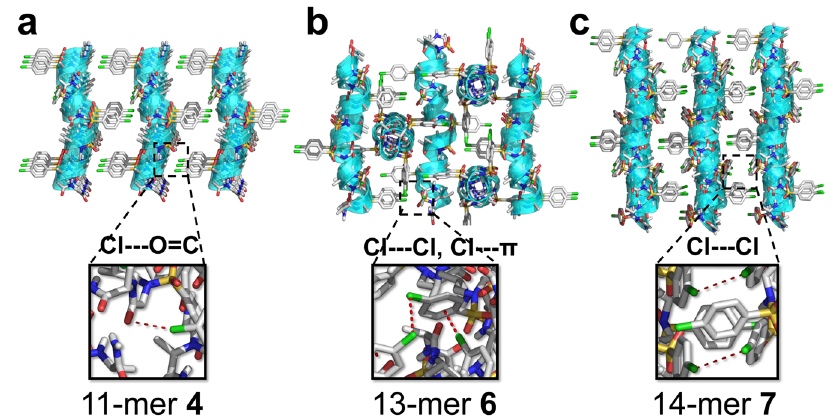
Fig. 3 Crystal packing of foldamers 4, 6, and 7. a Crystal packing of 11-mer 4 . b Crystal packing of 13-mer 6 . c Crystal packing of 14-mer 7 . The intermolecular Cl···O = C, C ‒ Cl···Cl ‒ C, and C ‒ Cl··· π interactions are indicated as red dashed line in insets. The disordered solvent THFs/pentanes (in 11-mer 4) , acetonitriles (in 13-mer 6 ) or chloroforms (in 14-mer 7 ) are excluded from the crystal lattice.